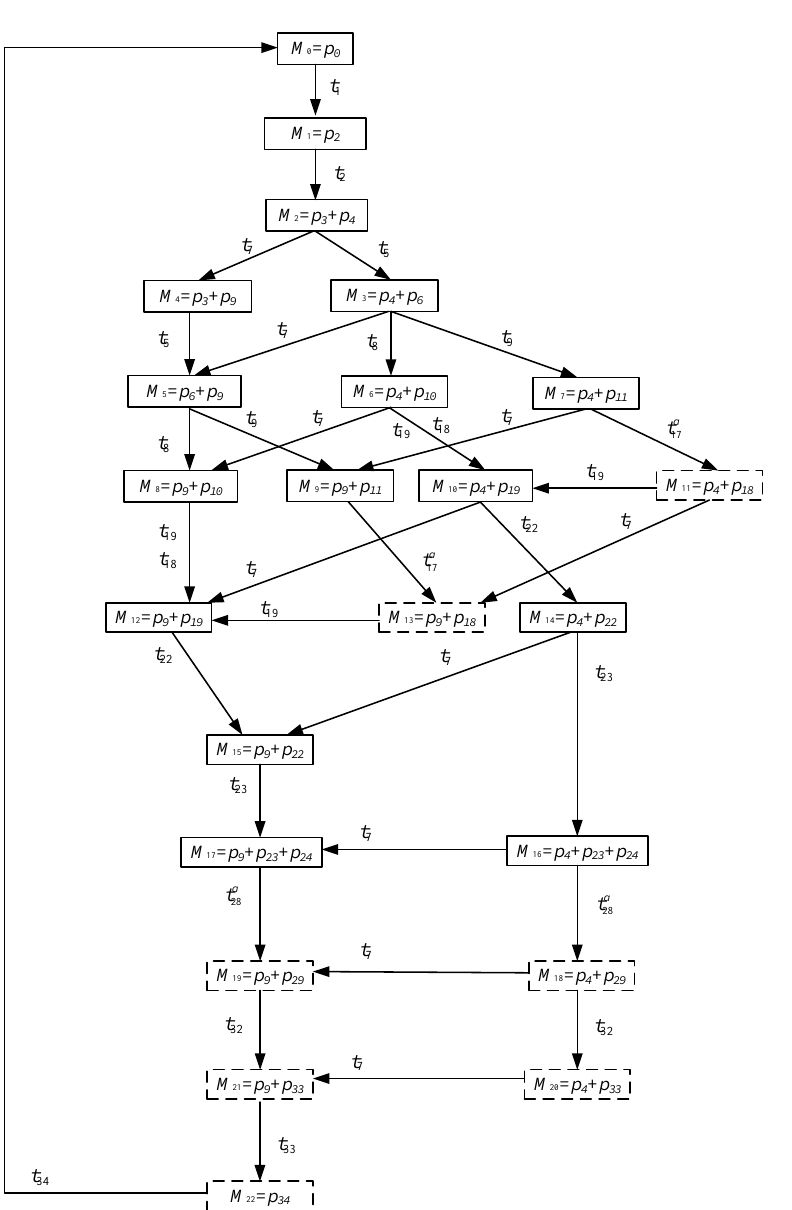
Figure 18. The basis attack model G B